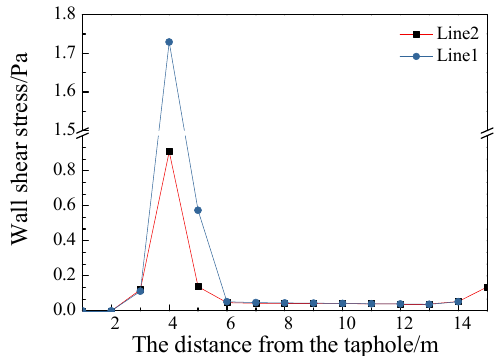
Figure 7. Wall shear stress on the line 1 (blue curve, cf. Figure 3b) and line 2 (red curve, cf. Figure 3b).